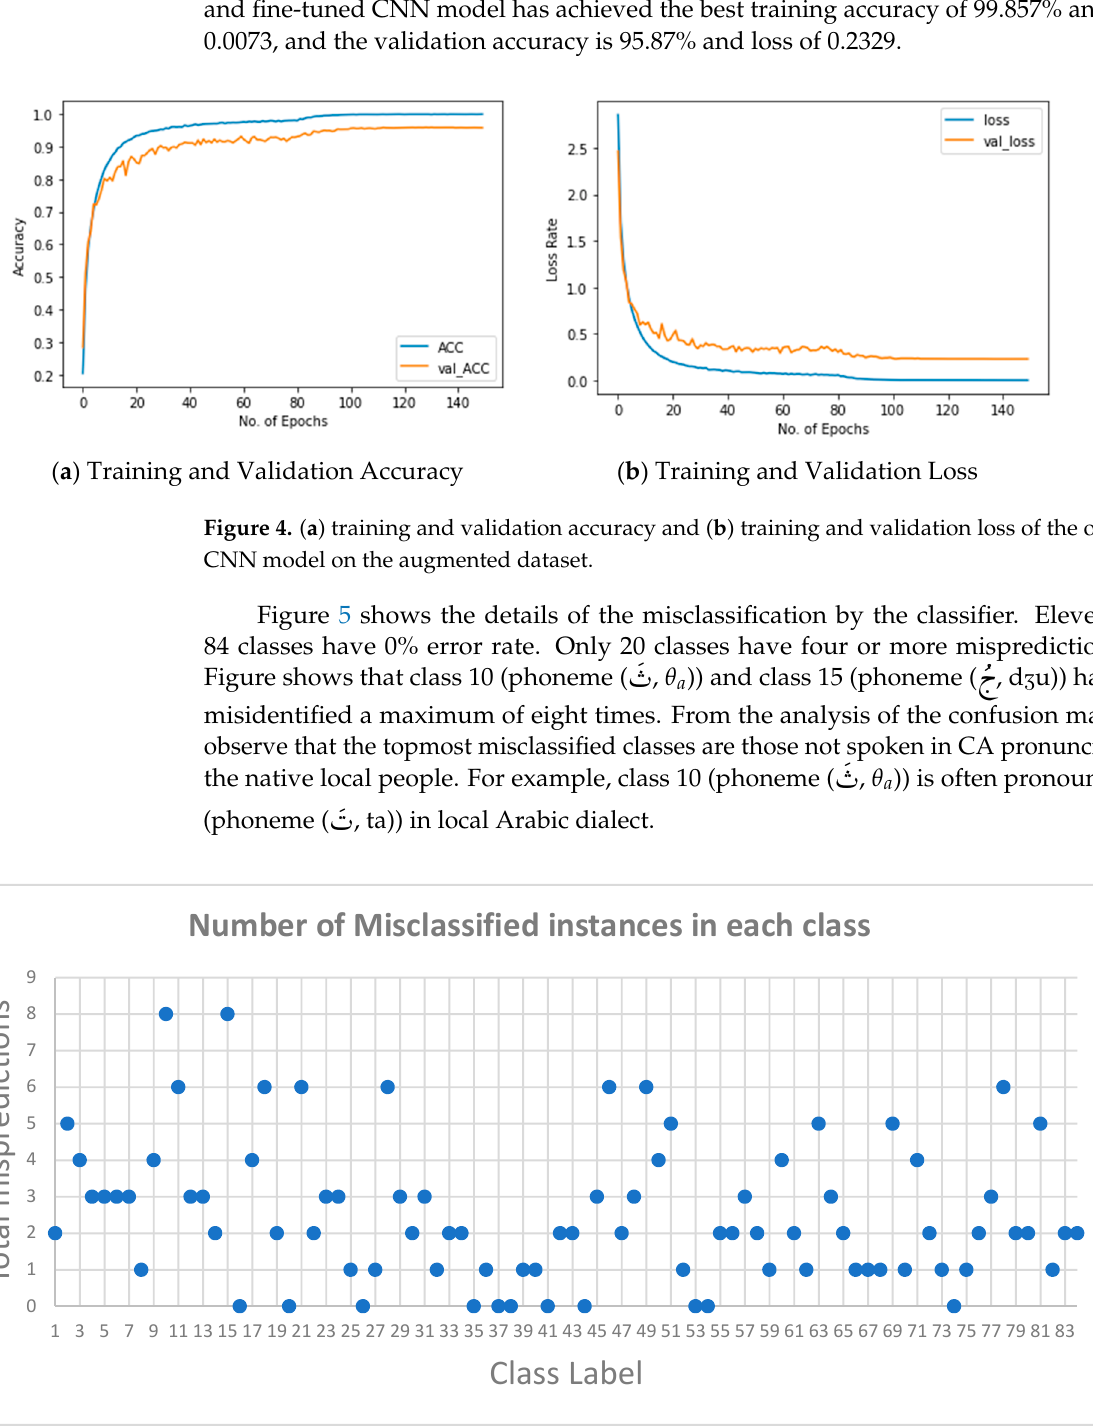
Figure 4a,b show the accuracy and loss of the optimized and fine-tuned CNN model.